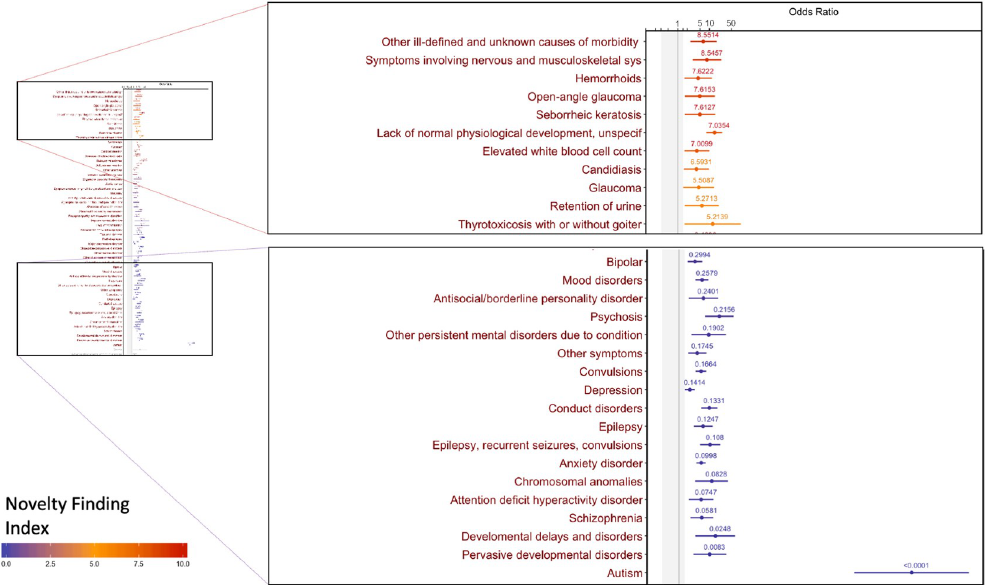
Fig 3. Significant associations for ASD presented as an odds ratio plot. Each dot represents the point estimate of the odds ratio computed from a logistic regression and the line indicates its 95% confidence interval. Each condition is color coded by its novelty finding index, the value of which is displayed above the confidence